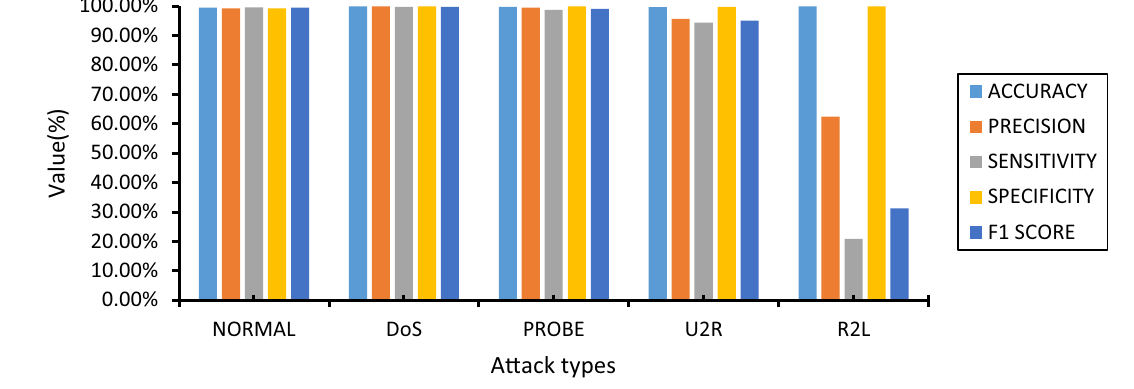
Fig. 4 Graphical representation of model performance on the attack types after feature selection